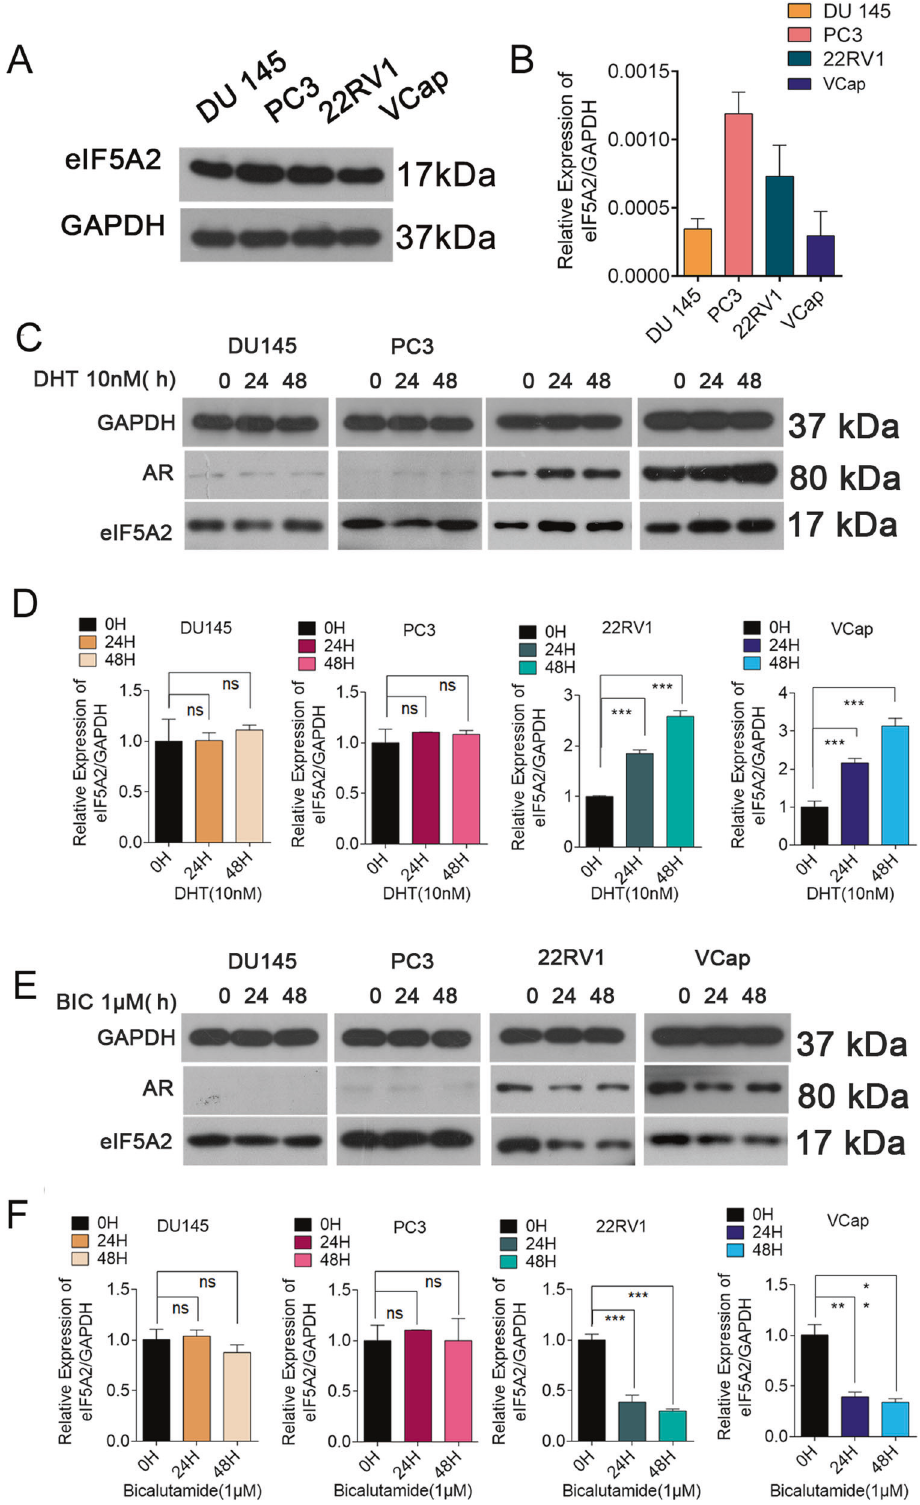
Fig. 1 Androgen Regulates eIF5A2 expression in human prostate cancer cells in an AR-dependent manner. A , B Protein and mRNA levels of eIF5A2 in four PCa cell lines determined by western blotting and qRT-PCR, respectively. C , D Expression of eIF5A2 and AR in four PCa cell lines treated with DHT (10 nM) at 0, 24, 48 h. E , F Expression of eIF5A2 and AR in four PCa cell lines treated with bicalutamide (1 μ M) at 0, 24, 48 h(NS, no signi fi cance, ** P < 0.01,*** P < 0.001 versus 0 h).